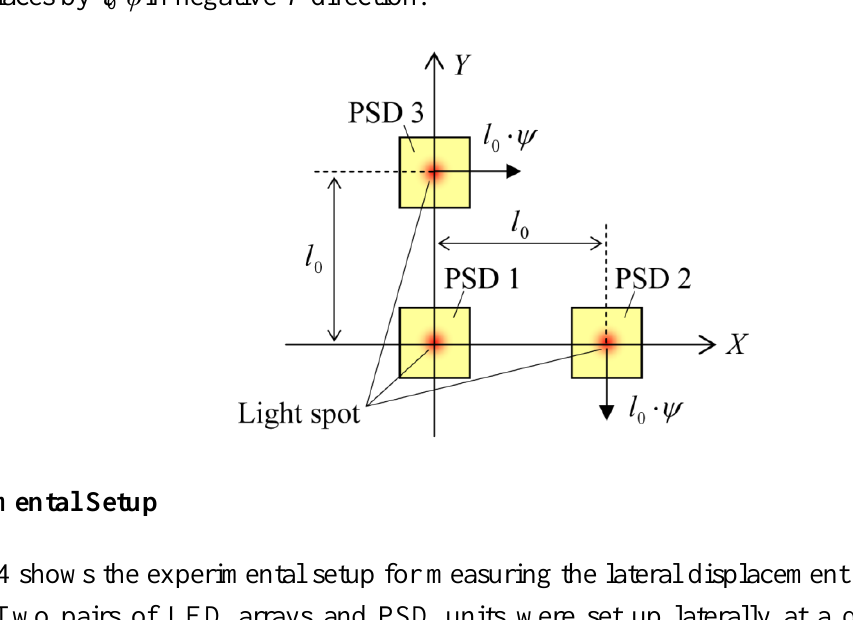
PSD surface by the lens in response to the torsional motion of the upper layer. The schematic shows the XY -plane. The original point for the torsional motion is located at the center of the PSD1. If the upper layer was counterclockwise rotated with the angle ψ , the light spot on the PSD3 displaces by l ∙ ψ in X -direction, and the light spot on the PSD2 0 displaces by l ∙ ψ in negative Y 0